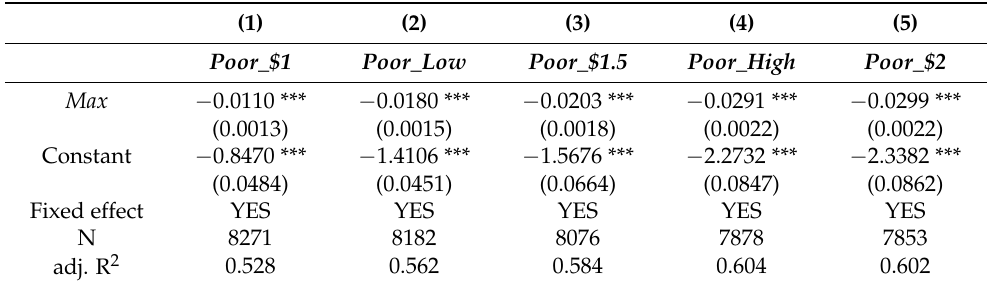
Table 8. Impact of extreme heat on groups with a probability of poverty less than